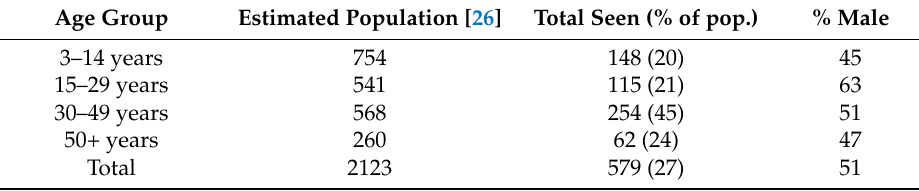
Table 3. Age groups as percent of estimated population and sex of people who took